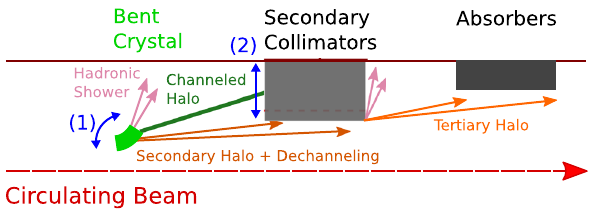
Fig. 2 Illustrative view of the crystal angular scan (1) and of the col- limator linear scan (2) that are used to demonstrate experimentally the onset of channeling. Angular scans are used to find the optimum channeling orientation when nuclear losses are minimized. Collimator scansprobethedistributionofthechanneledhaloandthede-channeling region